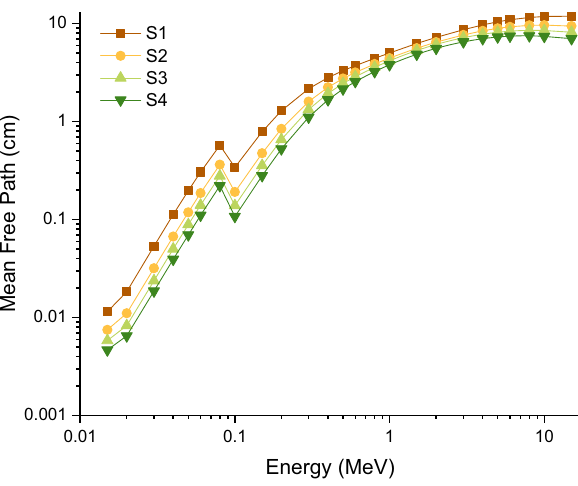
Figure 10: Variation of mfp ( cm ) with photon energy ( MeV ) for all S1 – S4 glasses.